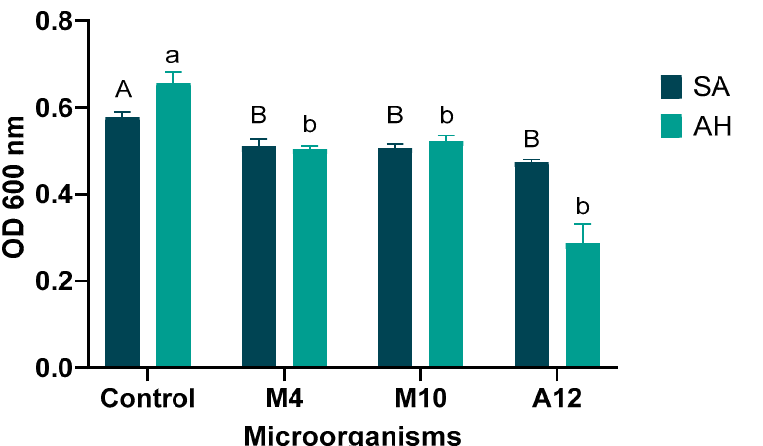
Figure 3. Antibacterial activity of the cell-free extracellular products (CFECP) of L. lactis A12, P. megaterium M4, and Priestia sp. M10 against S. agalactiae (SA) and A. hydrophila (AH). Capital letters indicate significant differences between each probiotic against the control in Streptococcus agalactiae treatment ( p < 0.05). Lower-case letters indicate significant differences of each probiotic against the control in Aeromonas hydrophila treatment ( p < 0.05). Data represent mean ± SEM ( n = 3).